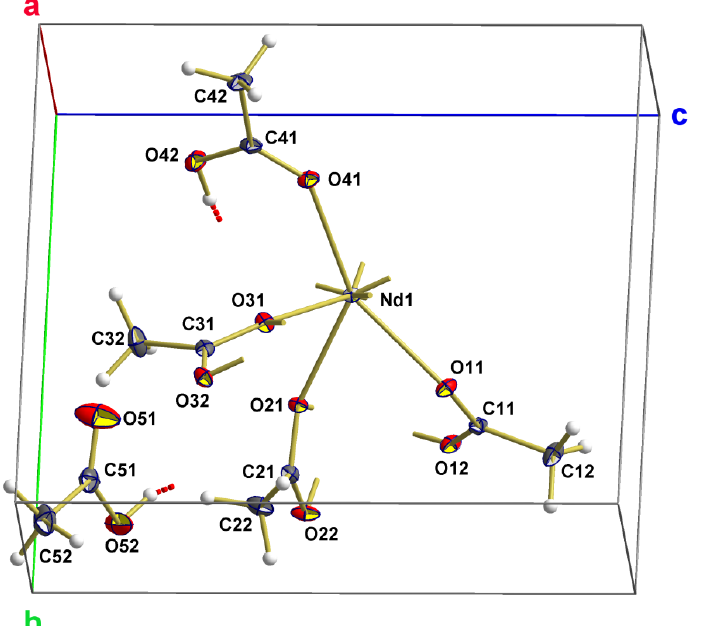
Figure 3. Unit cell and labelling scheme of the atoms in the asymmetric unit of the RE(OAc) 3 · 2AcOH structure type visualized for RE = Nd. All atoms are drawn as thermal displacement ellipsoids of the 40% level. Hydrogen bonds are indicated as broken sticks in red, additional RE-O- bonds to RE atoms outside the asymmetric unit as shortened sticks.